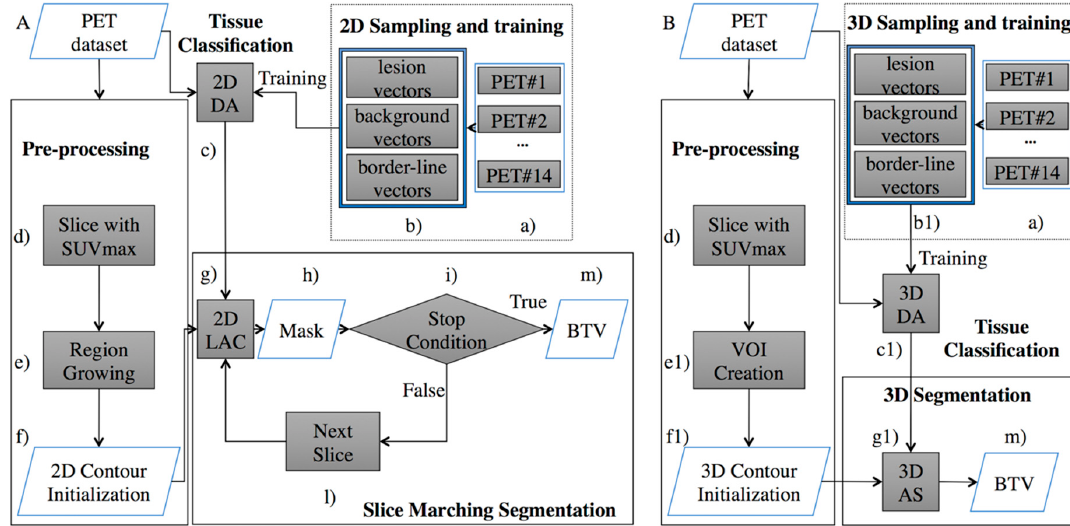
Figure 1. Comparison of the Positron Emission Tomography (PET) system proposed in the previous work ( A ) [24], and the implementation set out here ( B ). The proposed implementation substitutes the ‘Slice Marching Segmentation’ block ( A ) with the fully “3D Segmentation” block ( B ). Therefore, cross-slice information previously ignored is now being completely exploited. Moreover, the artificial stopping condition (step i) is no longer necessary. Additionally, (steps b, c, f, and g) were modified in order to provide a 3D sampling and training (step b1), a 3D tissue classification (step c1), 3D contour initialization (step f1), and 3D AS (step g1).